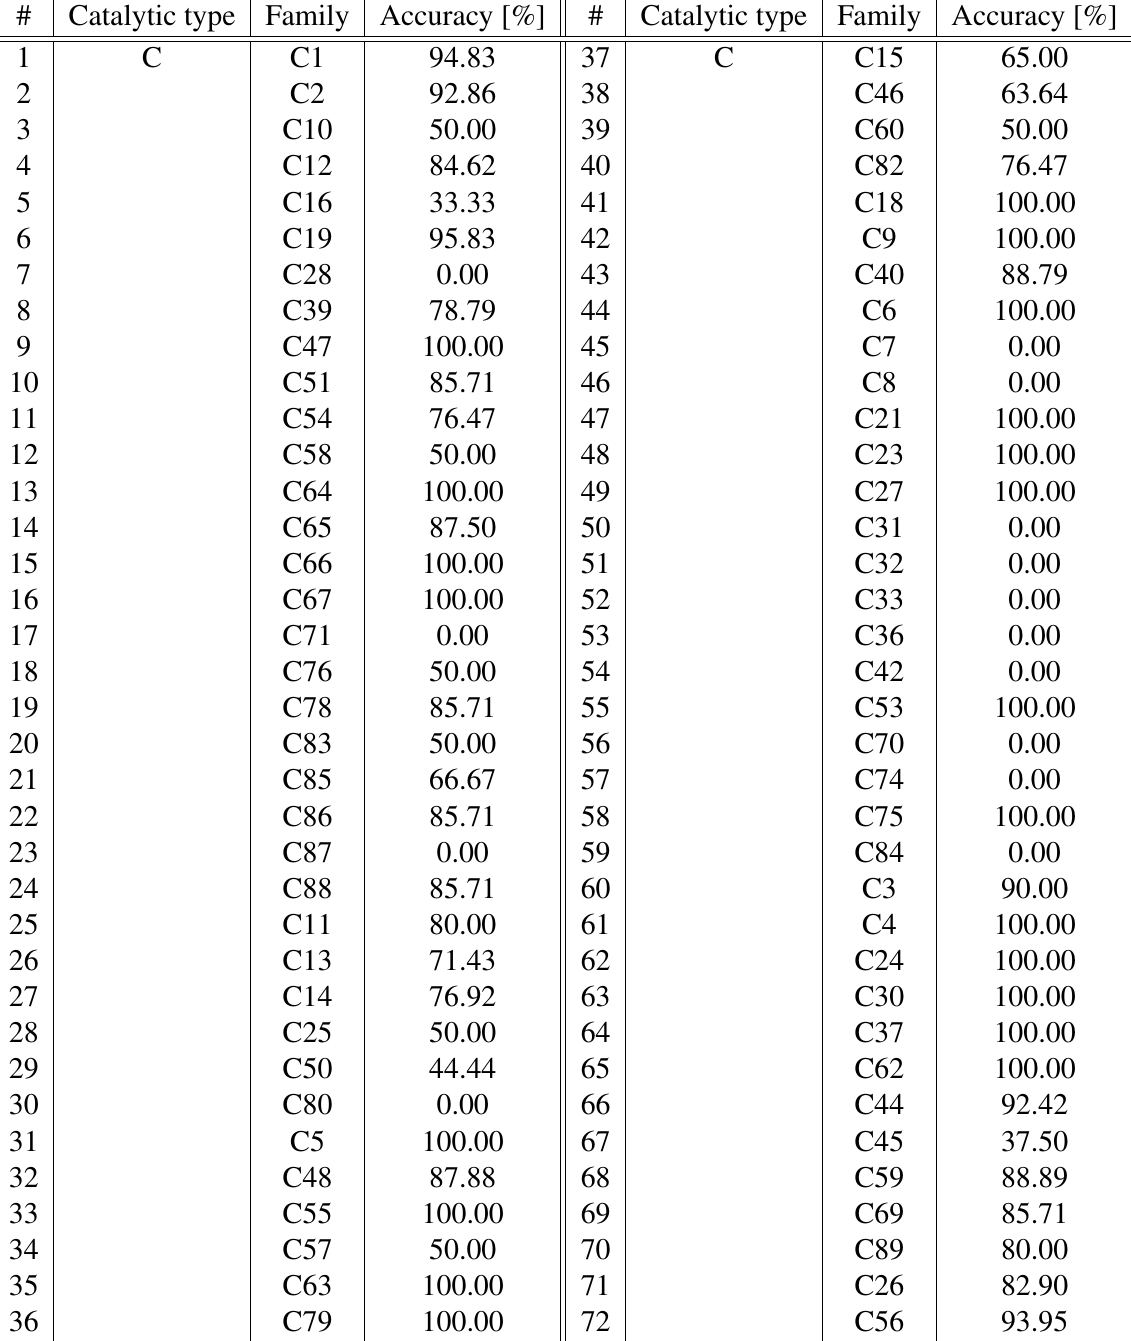
Table 8: Accuracy values for the SVM system for families from catalytic type C.